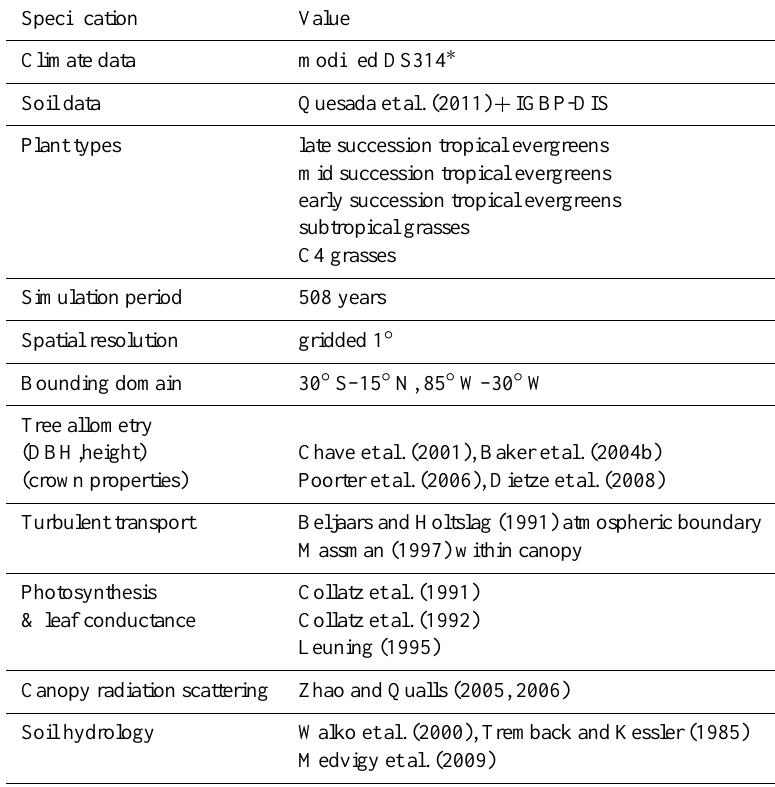
Table 1. Simulation constraints describing the spin-up process creating the initial boundary